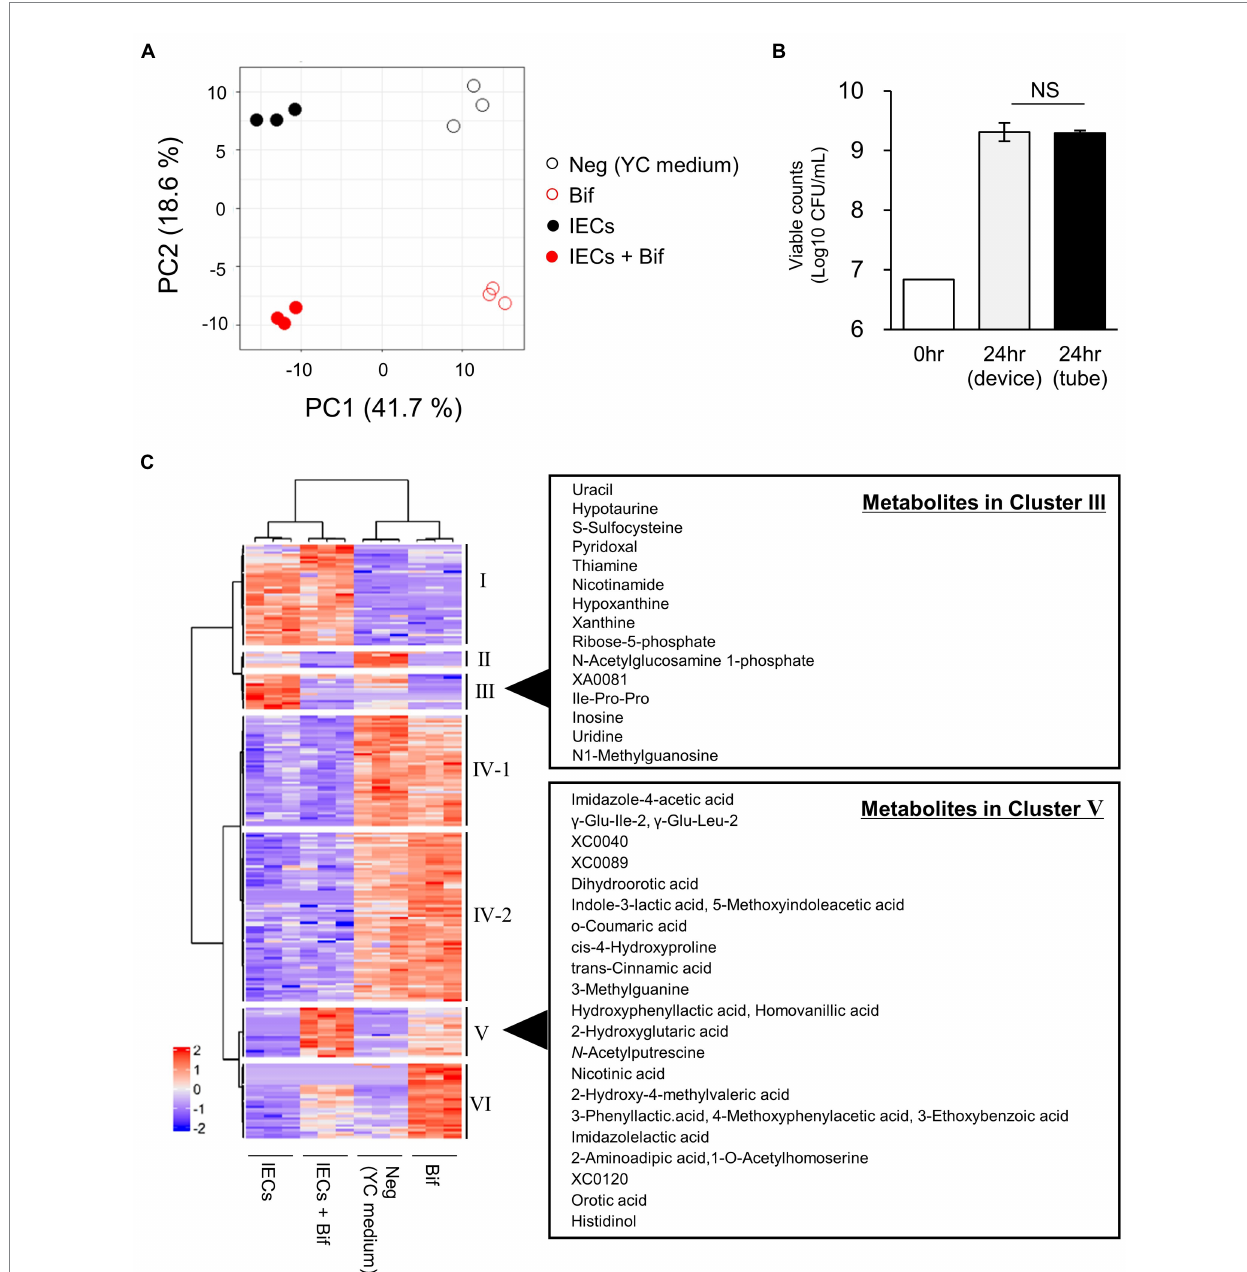
FIGURE 1 Comparison of the metabolites in the culture supernatants of Bifidobacterium breve MCC1274 with or without IECs. (A) PCA plot based on the total metabolites detected in the apical side of the device. Neg, YC medium; Bif, supernatant of B. breve MCC1274 monocultured for 24 h in tube. IECs, supernatant of IECs monocultured in the apical side of the co-culture device cultured for 48 h; IECs + Bif, supernatant of IECs co-cultured with B. breve MCC1274 in the apical side of the co-culture device cultured for 24 h. (B) Viable cell count of B. breve MCC1274 before (0 h) and after (24 h) cultivation in the tube as a monoculture, and in the device as a co-culture with IECs. The data represent the average of two samples (0 h) and six samples (24 h) from each group, from two independent experiments (Average ± standard deviation). Standard deviation were not described in before cultivation samples. NS, not significant ( p = 0.83, Welch’s t -test). (C) A heatmap of the scaled intensity value of each metabolite with a significant difference ( q -value <0.1) in the Kruskal–Wallis and Benjamini–Hochberg